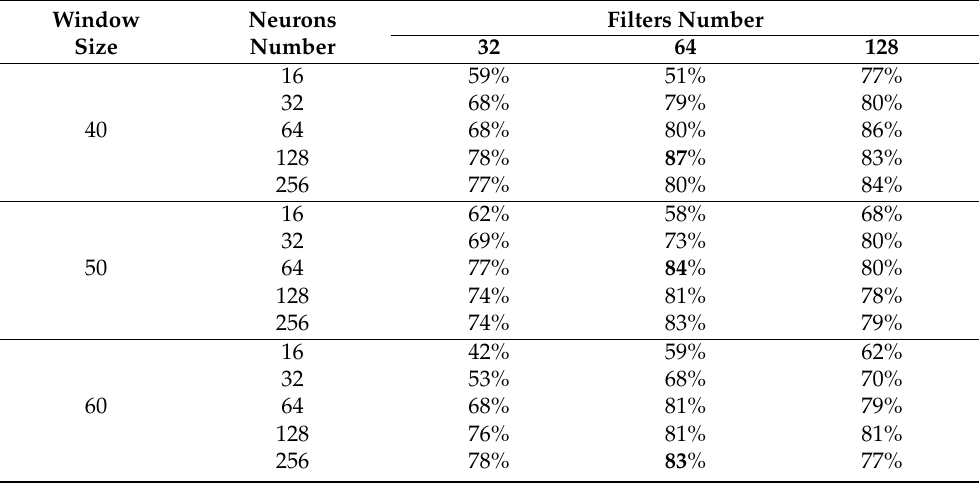
Table 5. The accuracy of the model in Experiment 3 using a different number of convolutional filters and neurons for recursive layers.